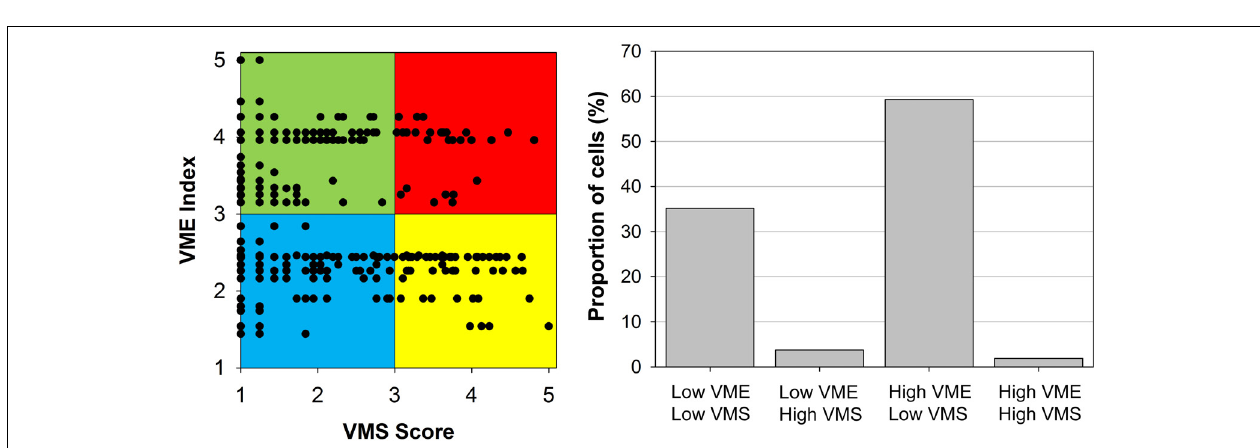
FIGURE 6 | Applying the VME index and confidence index to the VME database: Charlie-Gibbs Fracture Zone. (a,b) VME index for all cells with data in the ICES VME database; (c,d) confidence index for all cells with data in the ICES VME database.